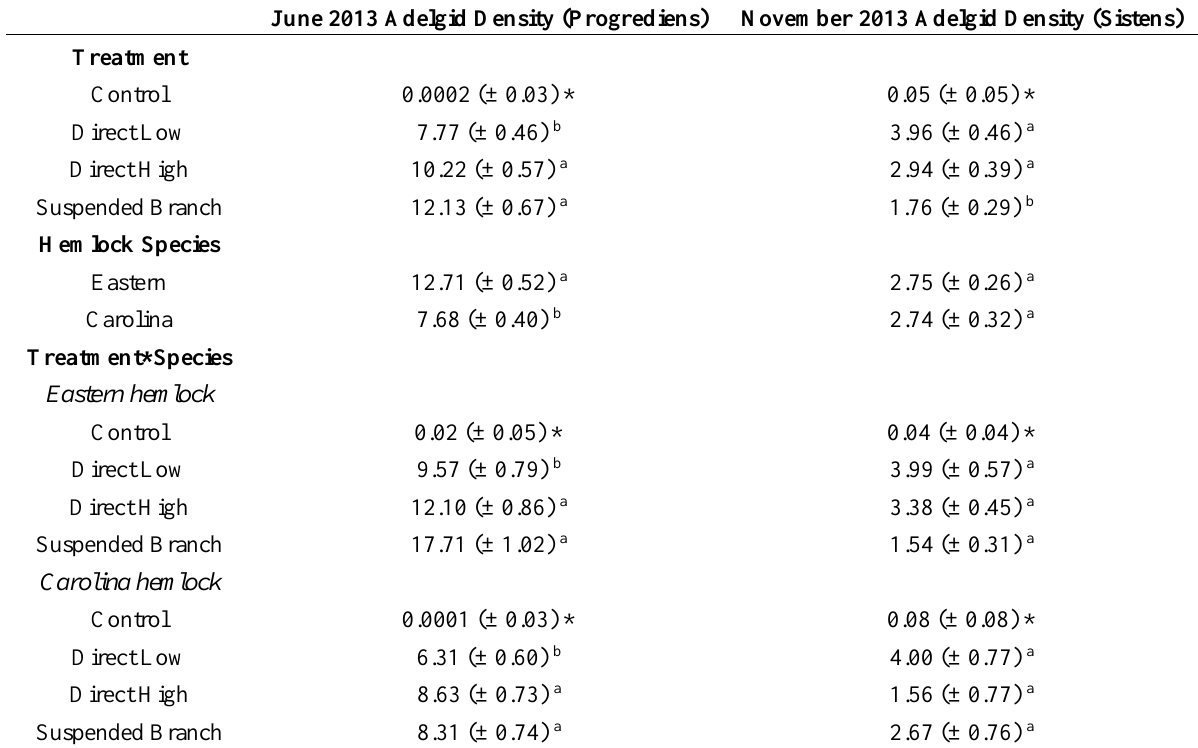
Table 2. Mean (± SE) infestation density of hemlock woolly adelgids (per 10cm twig sample) on eastern and Carolina hemlock seedlings three and eight months after exposure to sistens crawlers in March